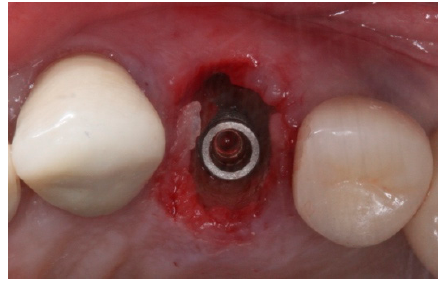
Figure 6. Intraoral oclusal view of morse taper implant placed on #24 site after Osseodensification bone instrumentation.